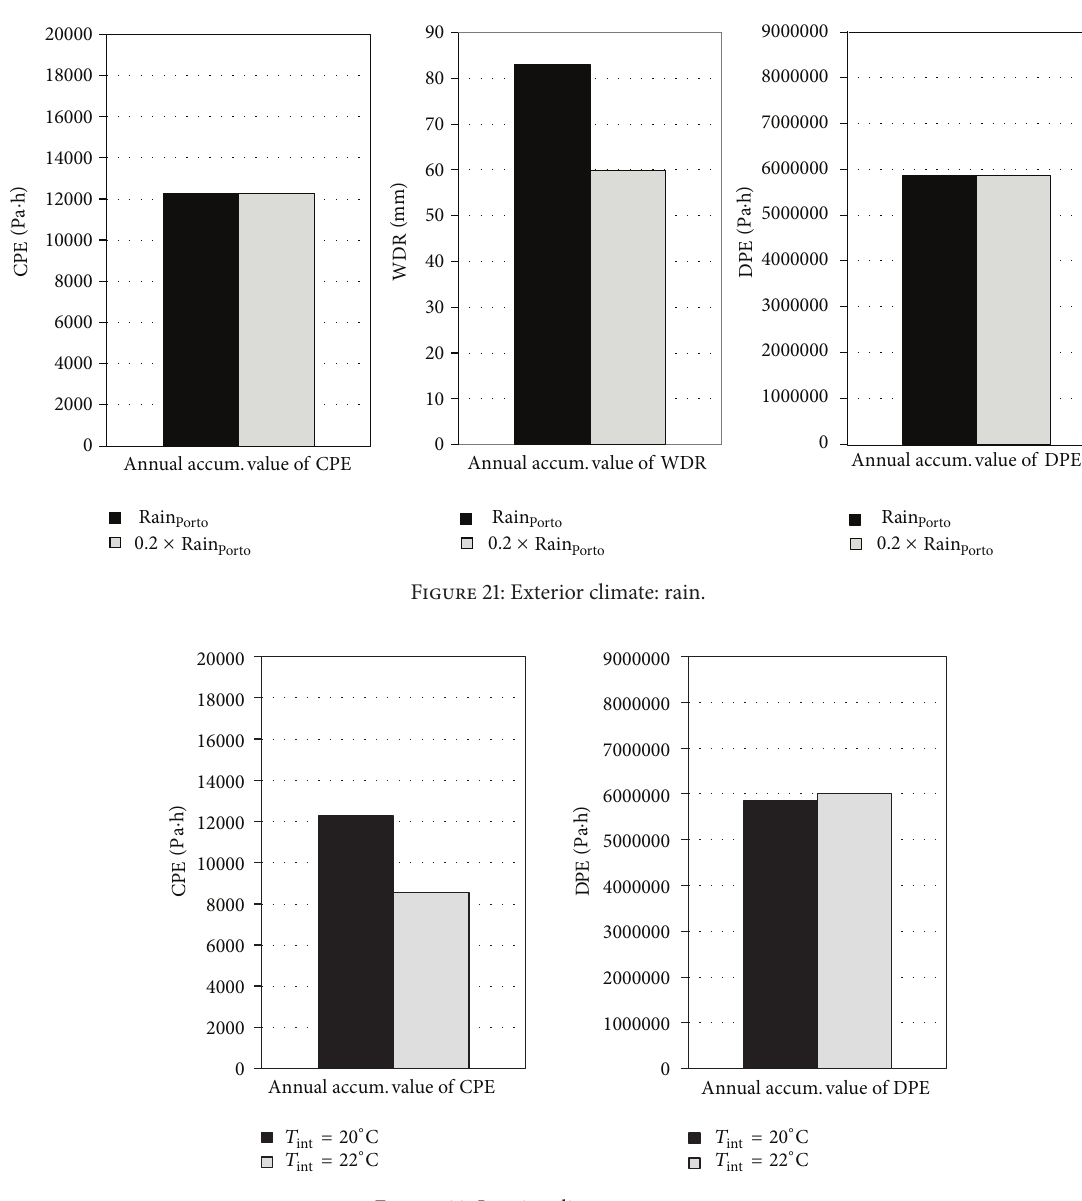
Figure 22: Interior climate: